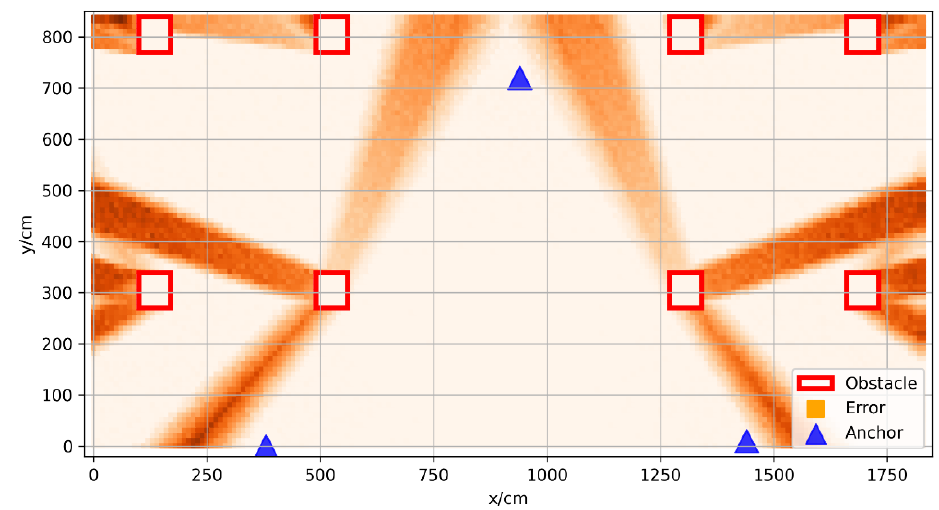
Figure 6. The approximately optimal anchor layout.